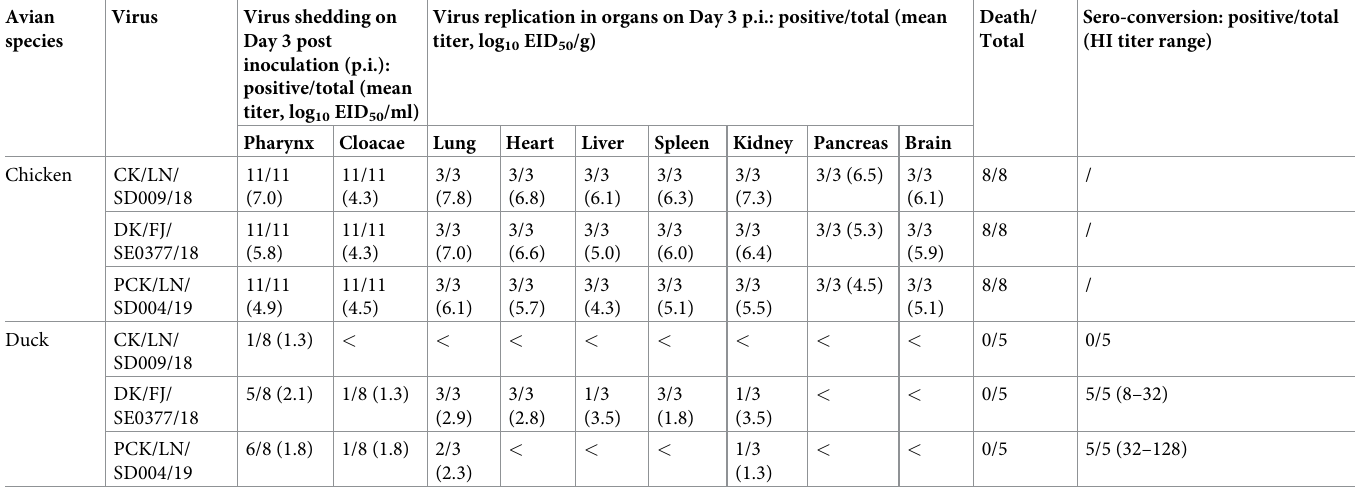
Table 2. Replication and virulence of H7N9 viruses in chickens and ducks a . Avian species